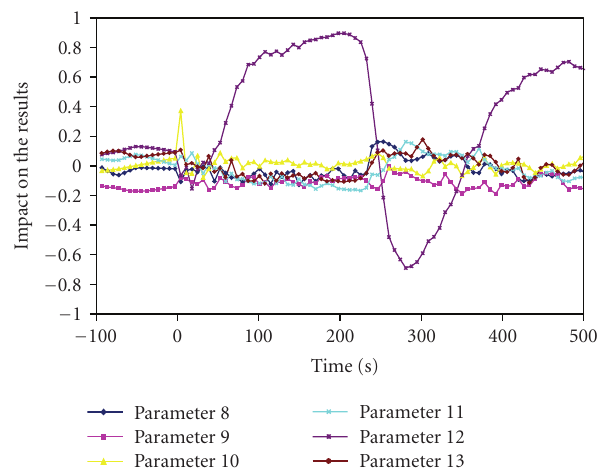
Furthest pressure changes depend on the amount of removed steam for in-house needs. As could be seen from the pre- sented comparison, pressure losses in di ff erent parts of the MCC are predicted correctly using the developed